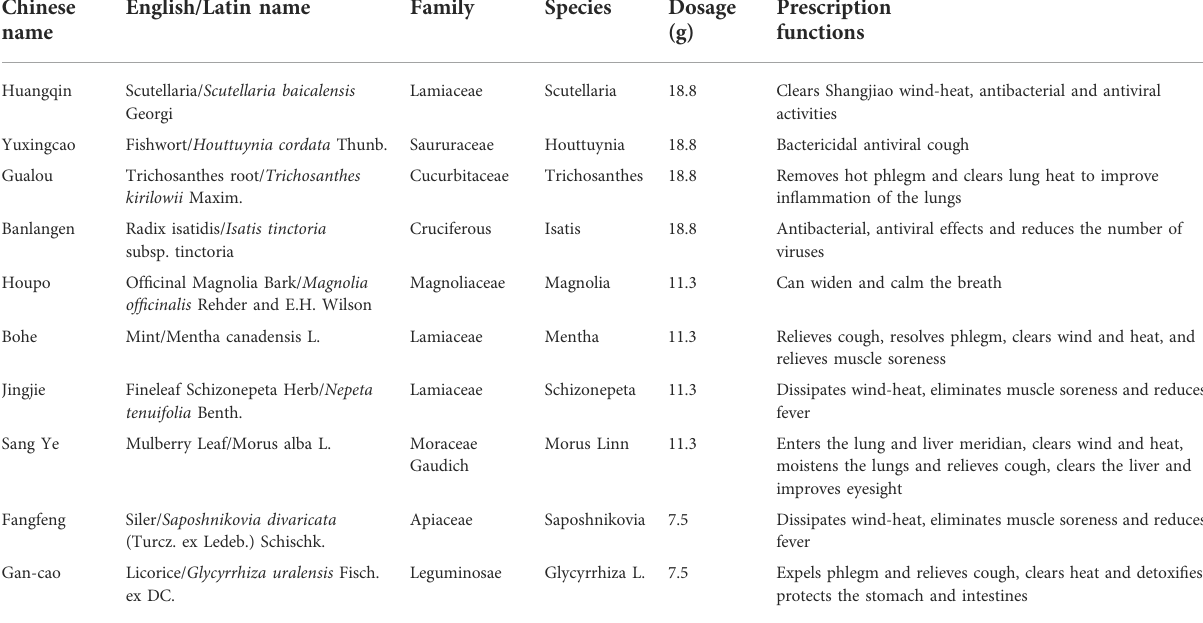
TABLE 2 Overview of TNRICM101 ingredients and the therapeutic ef fi cacies of each ingredient Lin et al.